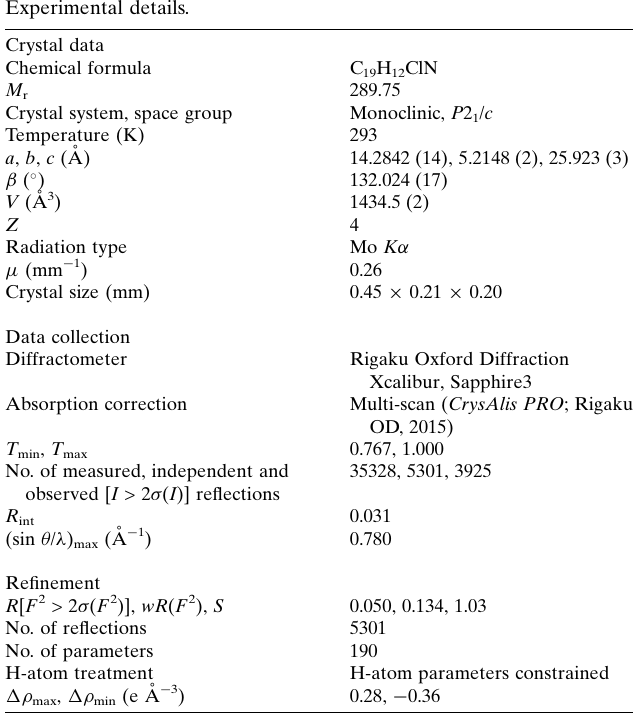
Table 2 Experimental details.